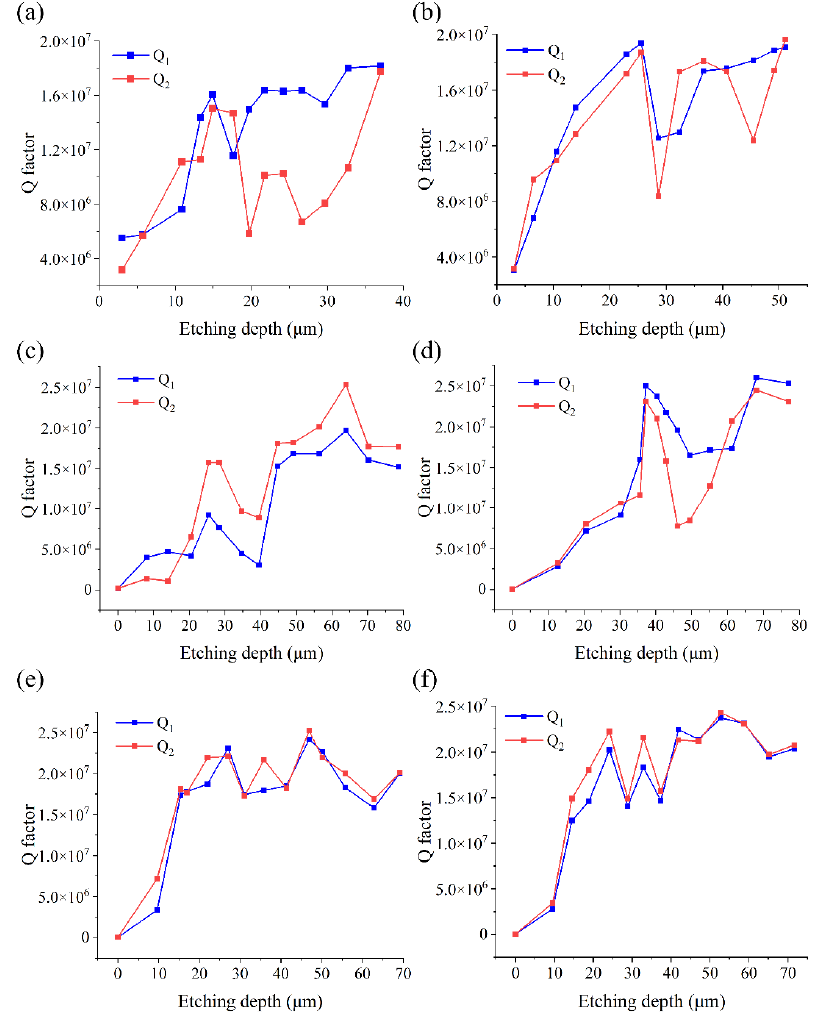
Figure 4. The variation of the Q factors of six resonators with chemical etching depth. ( a ) The variation of Q factor of GR01 with etching depth. ( b ) The variation of Q factor of GR02 with etching depth. ( c ) The variation of Q factor of GR03 with etching depth. ( d ) The variation of Q factor of GR04 with etching depth. ( e ) The variation of Q factor of GR05 with etching depth. ( f ) The variation of Q factor of GR06 with etching depth.